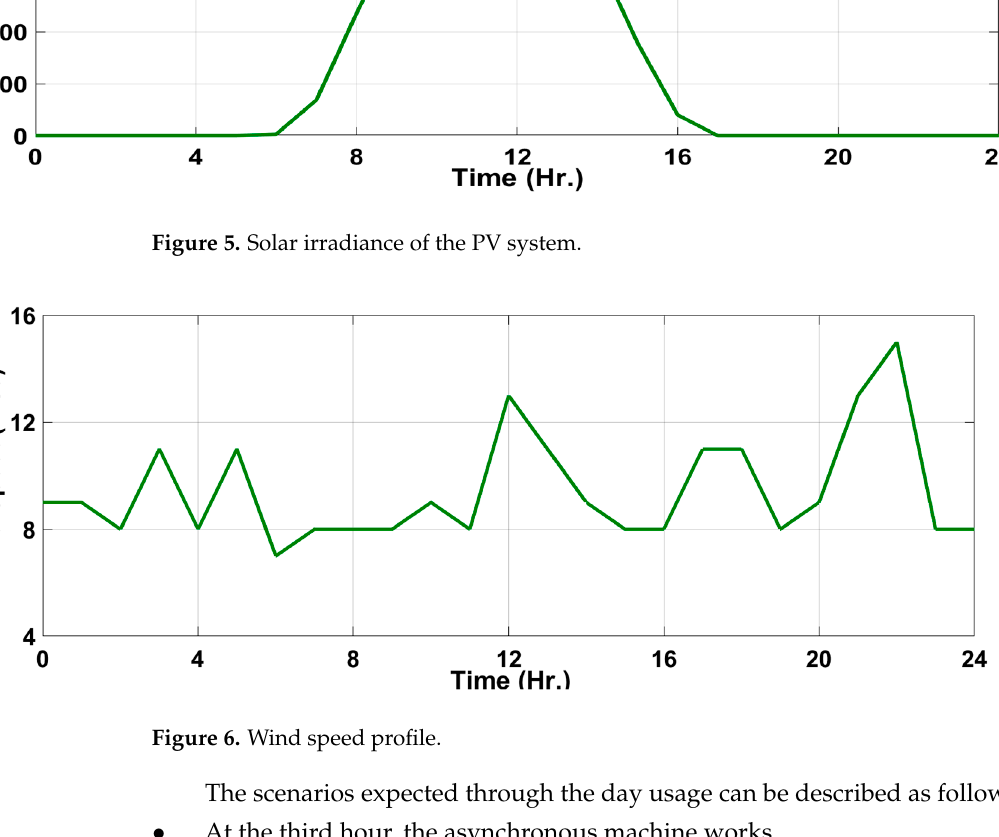
Figure 7. Load profile. ( a )